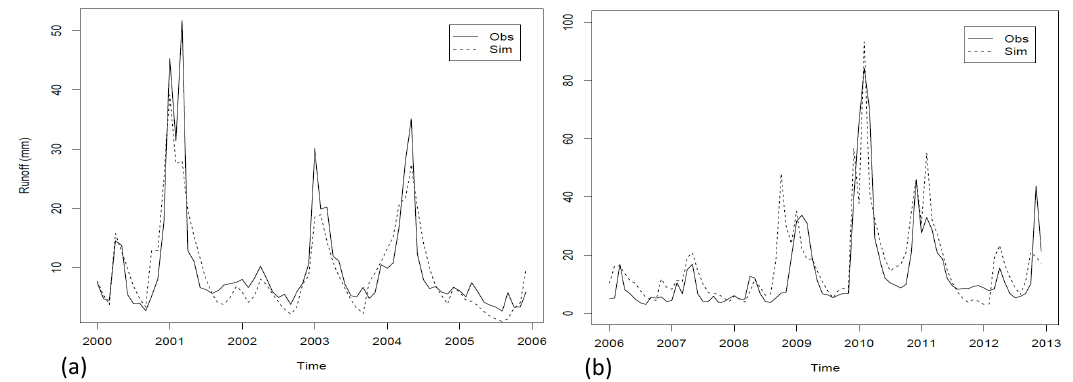
Fig. 4 Observed and simulated runoff (mm) for Fuensanta basin: (a) calibration for 2000–2005 period; and (b) validation for 2006–2012 period.